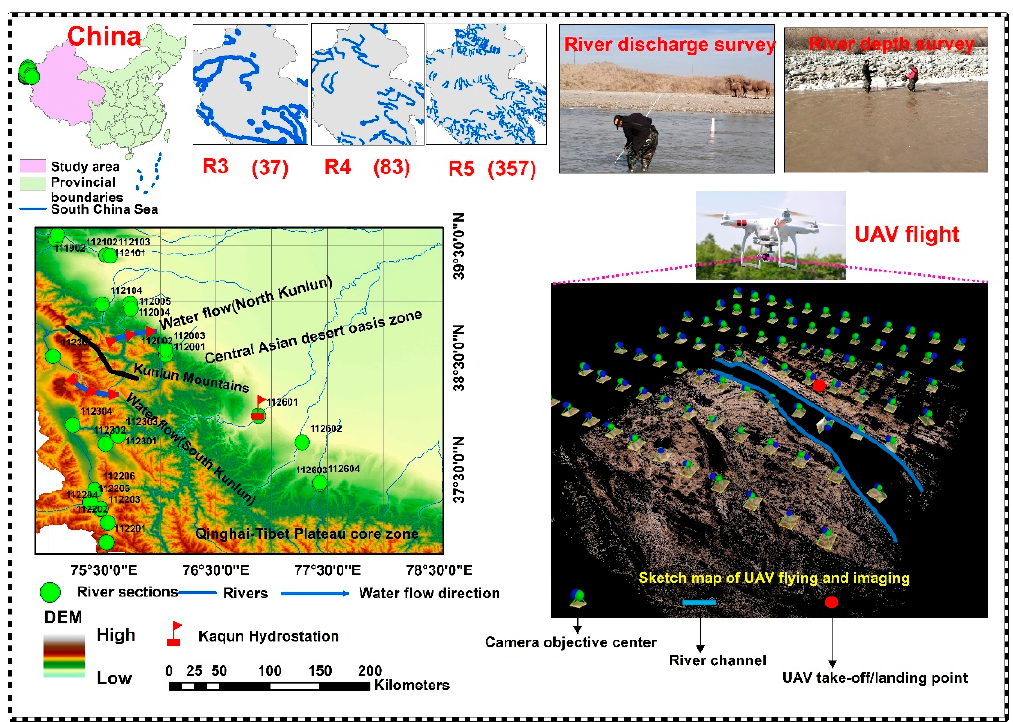
Figure 1. Study area and in-situ river hydrological parameters. R3 is a third-grade river, R4 is a fourth-grade river, and R5 is a fifth-grade river.